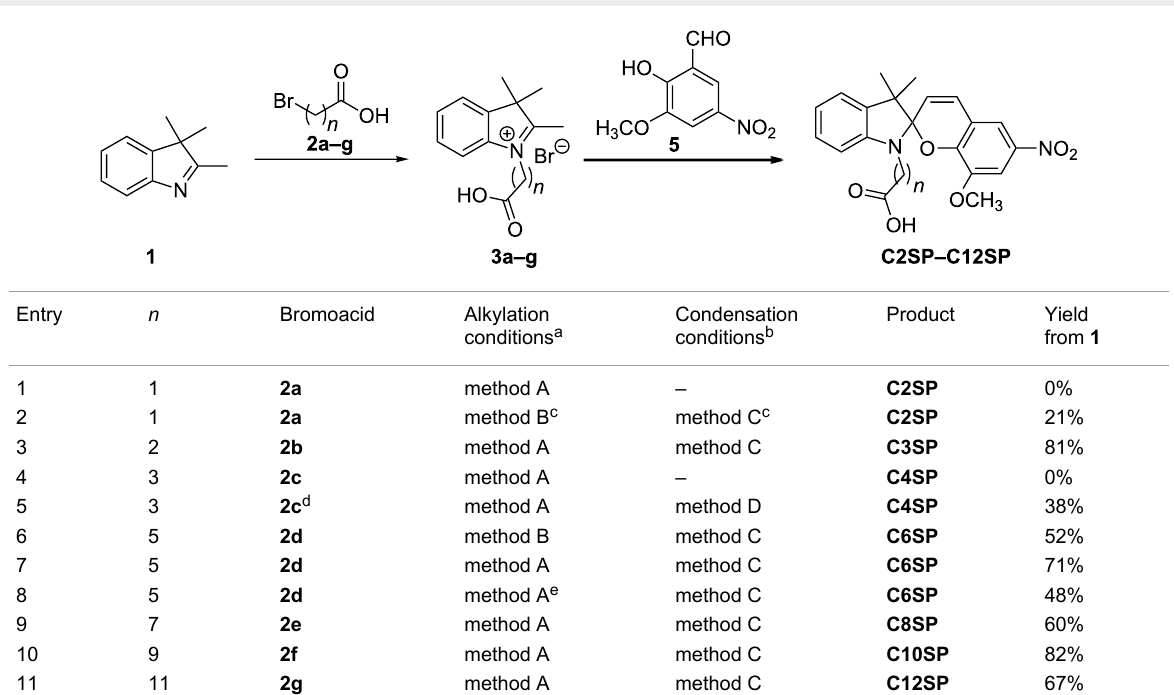
Table 1: Synthesis of spiropyrans C2–C12SP